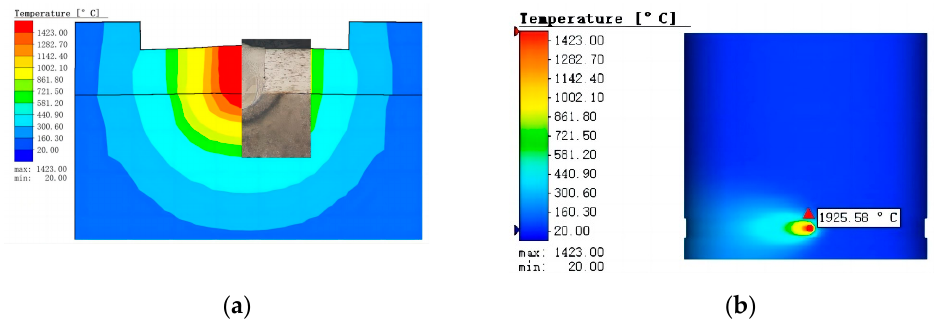
Figure 7. Numerical simulation comparison and temperature field simulation results: ( a ) Comparison of simulation and experimental results; ( b ) temperature field simulation results.